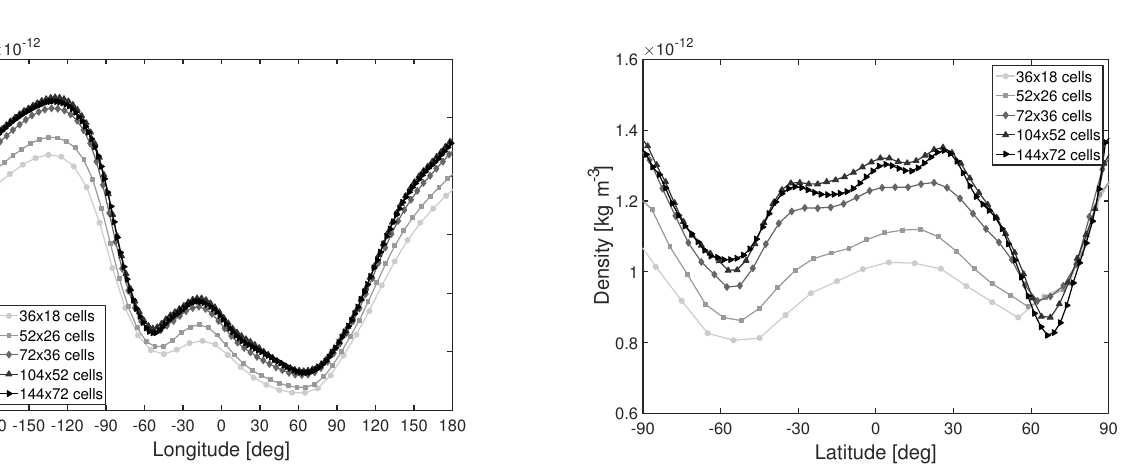
Figure 3. Grid sensitivity analysis at 0 ◦ longitude and 400km alti- tude (long × lat